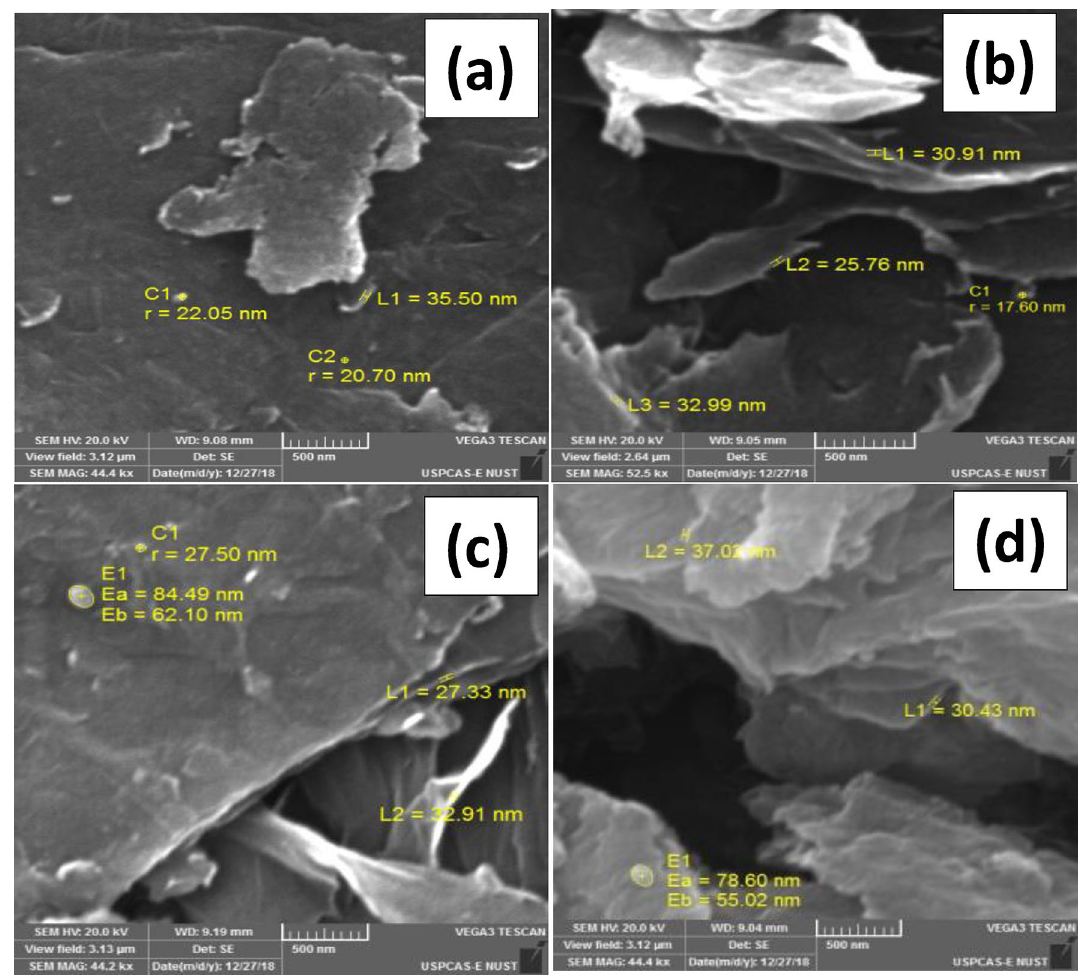
Figure 5. SEM images of GO/Iron Oxide nanocomposites samples for various concentration of iron oxides ( a ) 0.25% ( b ) 3% ( c ) 5% ( d )